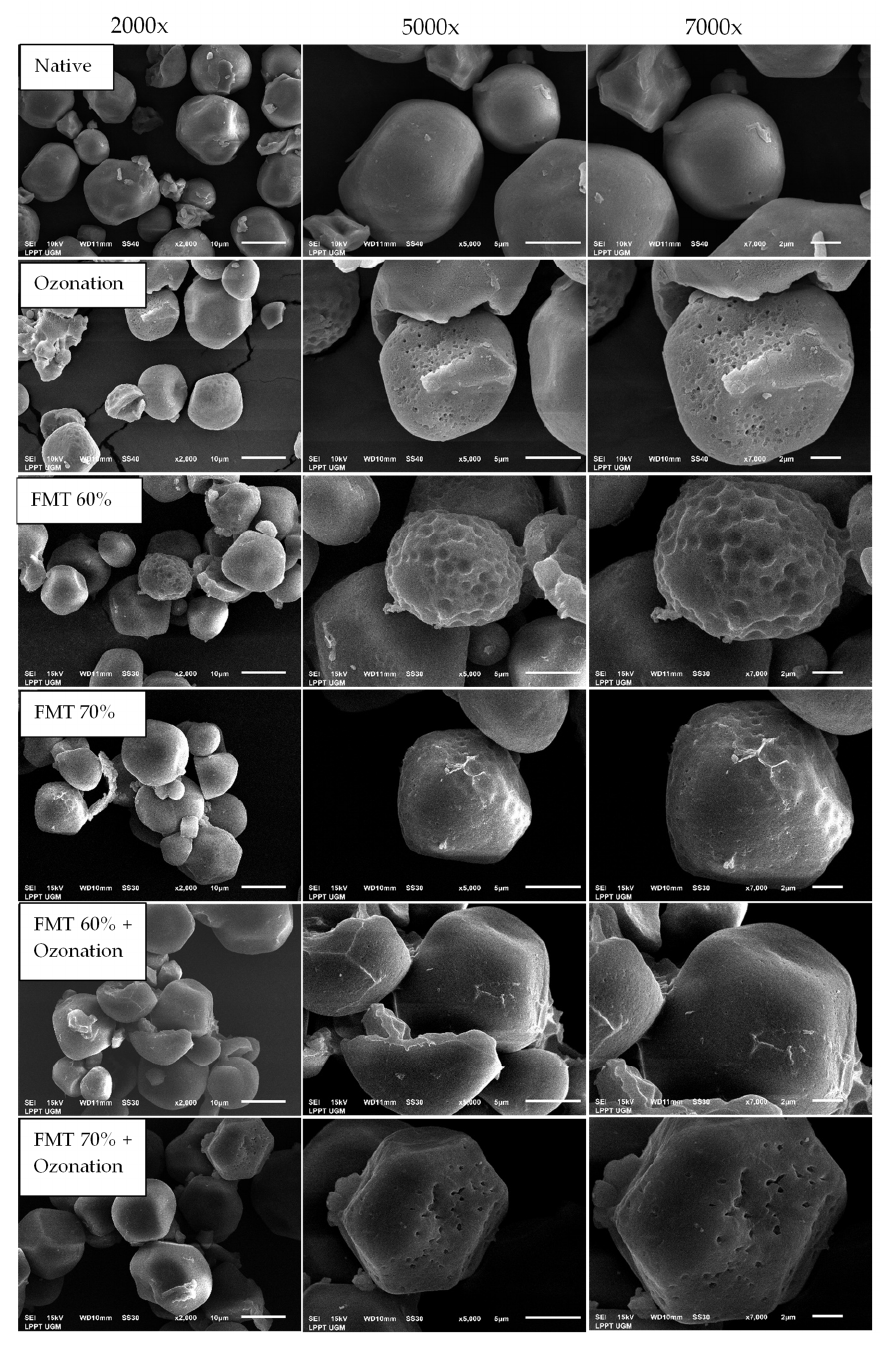
Figure 6. The particle morphology of native adlay starch and adlay starch modified by FMT and ozonation.